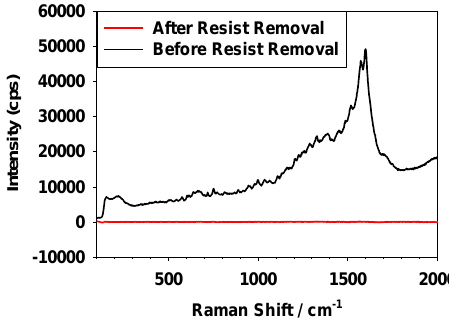
Figure 2. Representative Raman spectra of SMPs3 before and after resist removal.